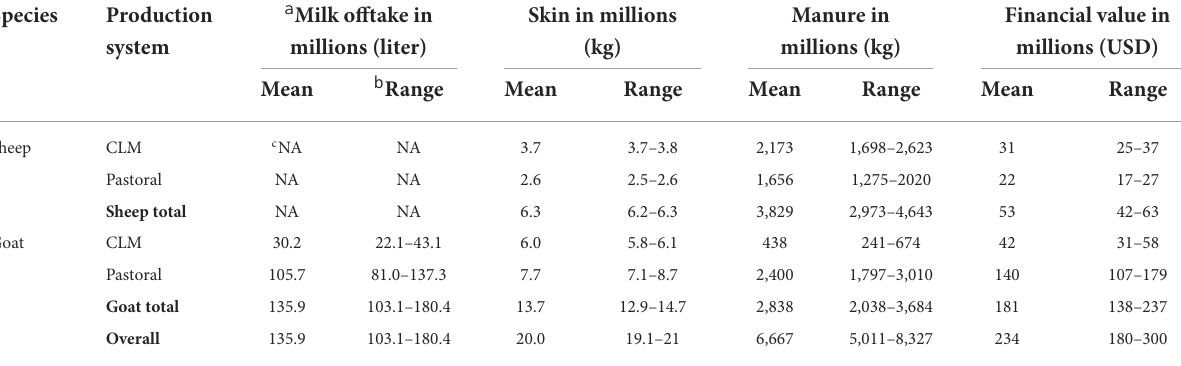
TABLE 5 The annual monetary value of secondary production outputs from small ruminants for year 2021.